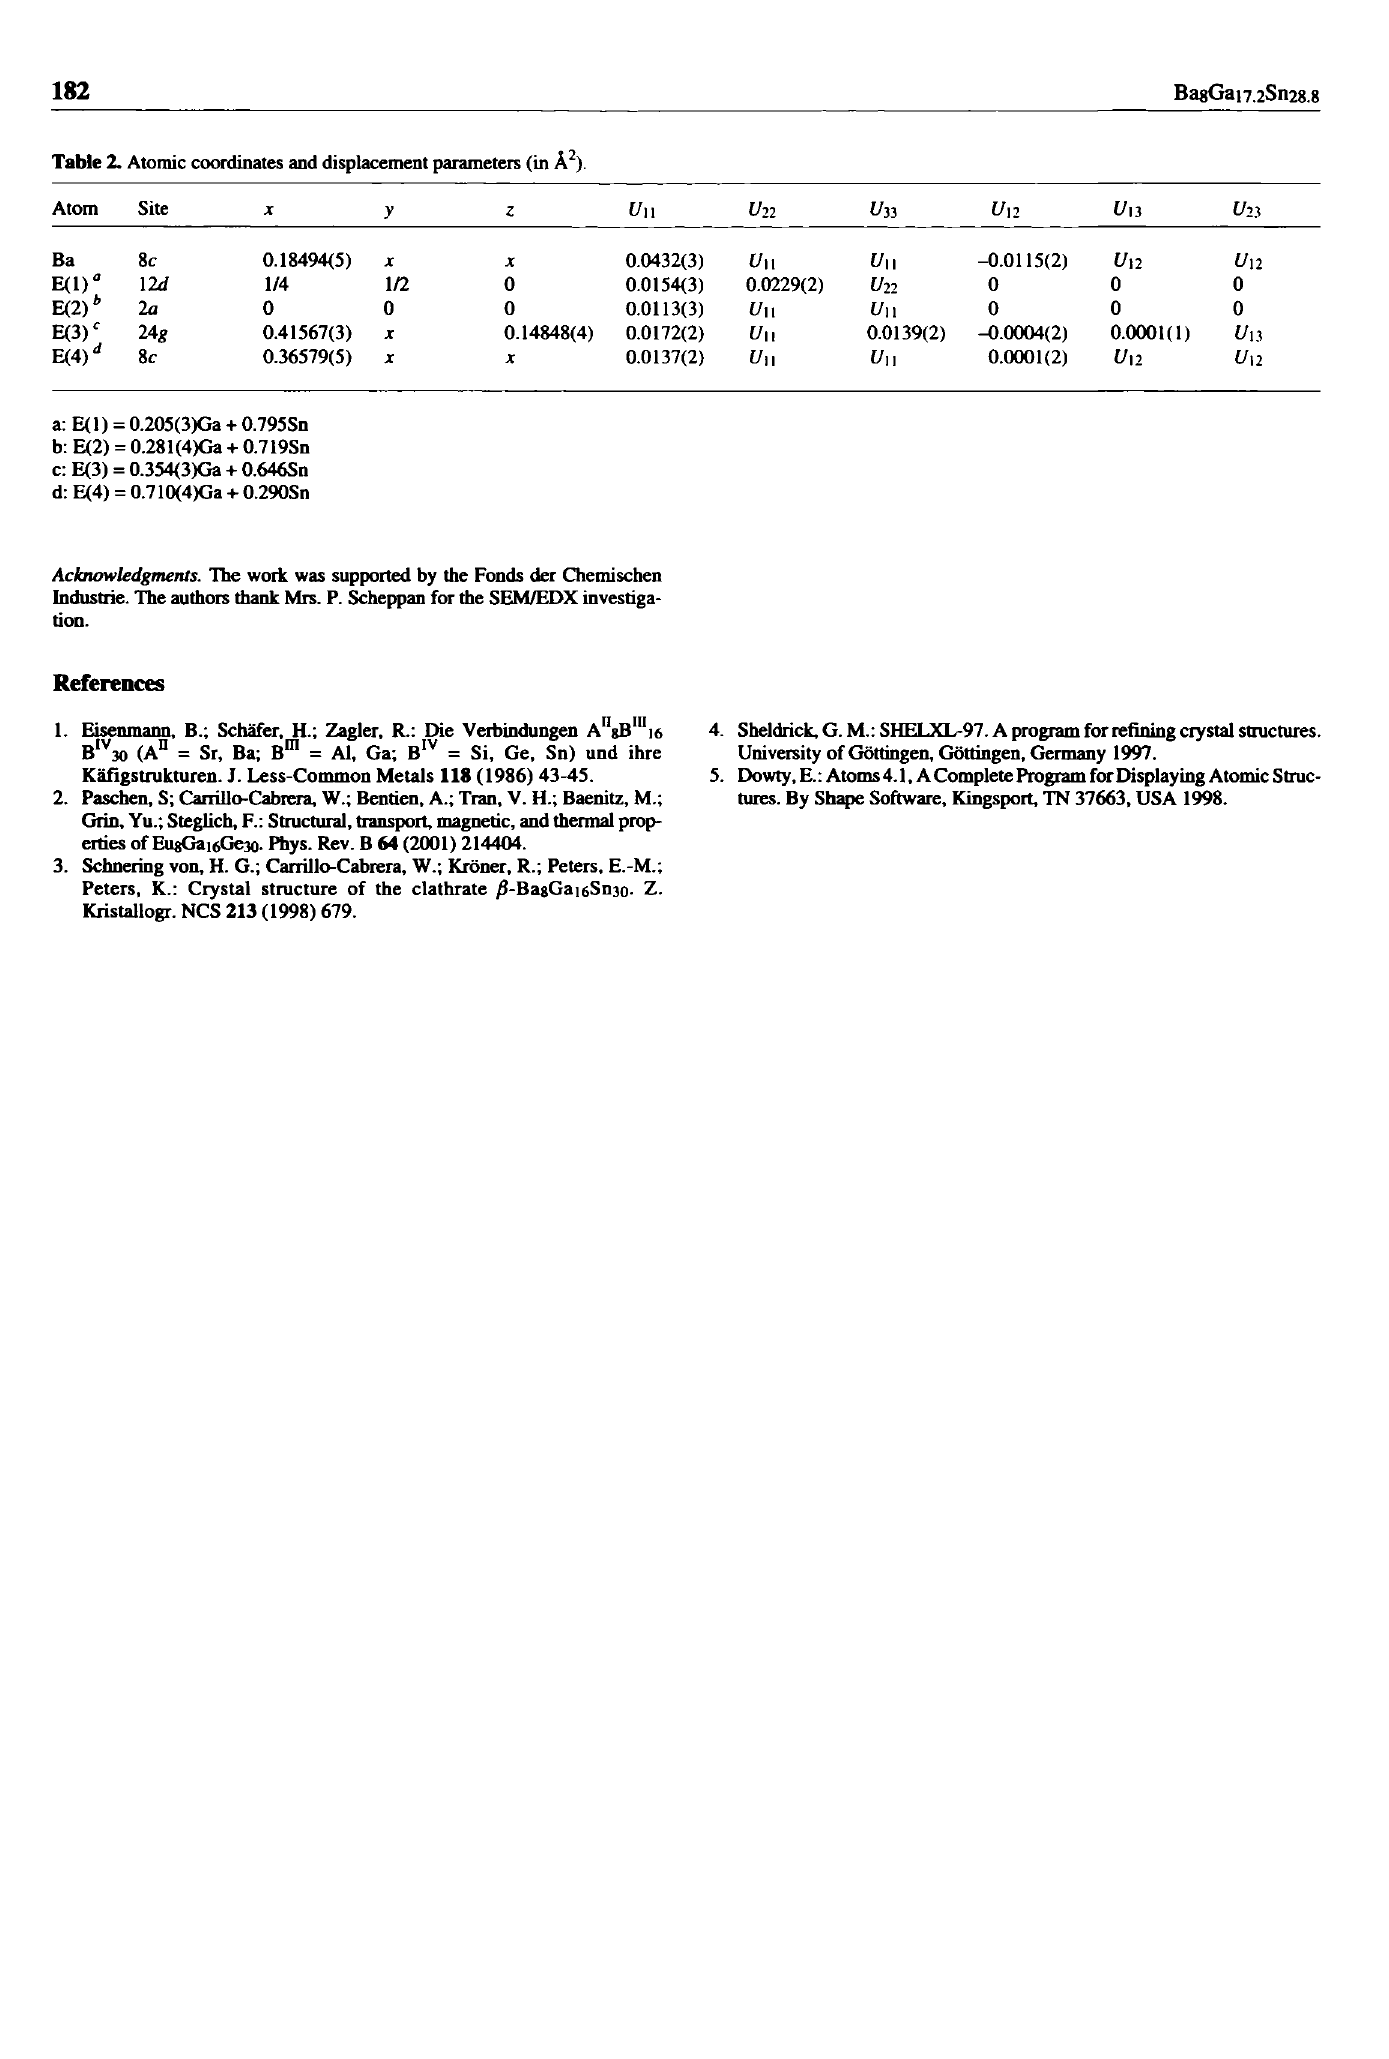
Table 2. Atomic coordinates and displacement parameters (in Â 2